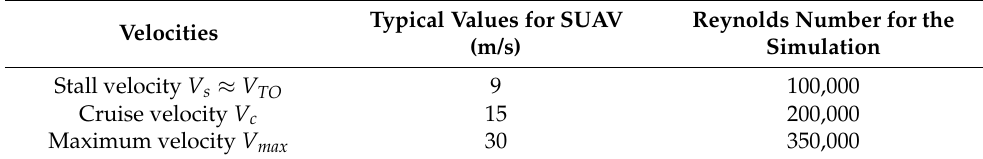
Table 4. Reynolds number calculation.